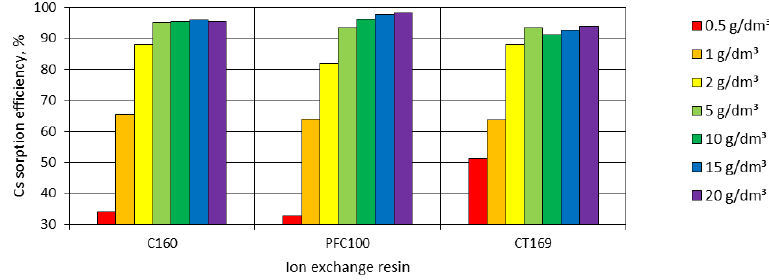
Figure 2. Influence of cesium concentration on cesium ion sorption efficiency.